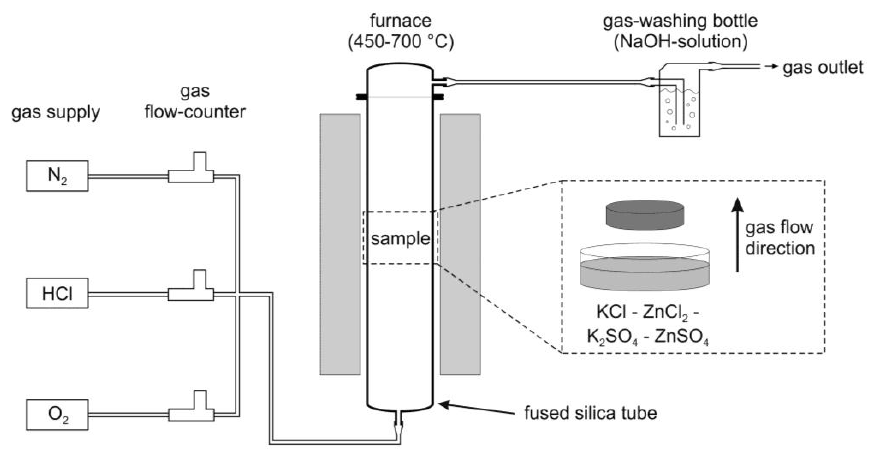
Figure 2. Schematic diagram of the experimental setup for lab-scale experiments.